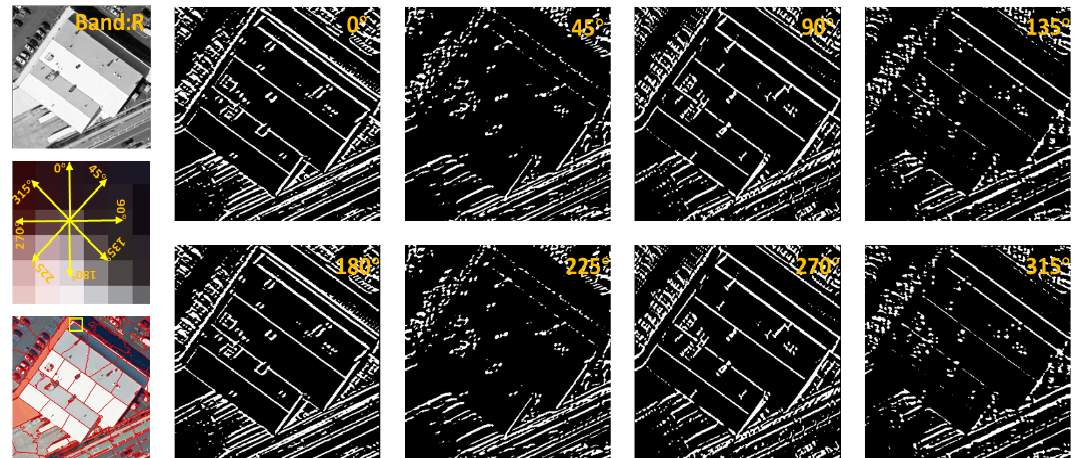
. 𝜎𝜎 𝑣𝑣 = 1 and 𝜎𝜎 𝑢𝑢 = 2